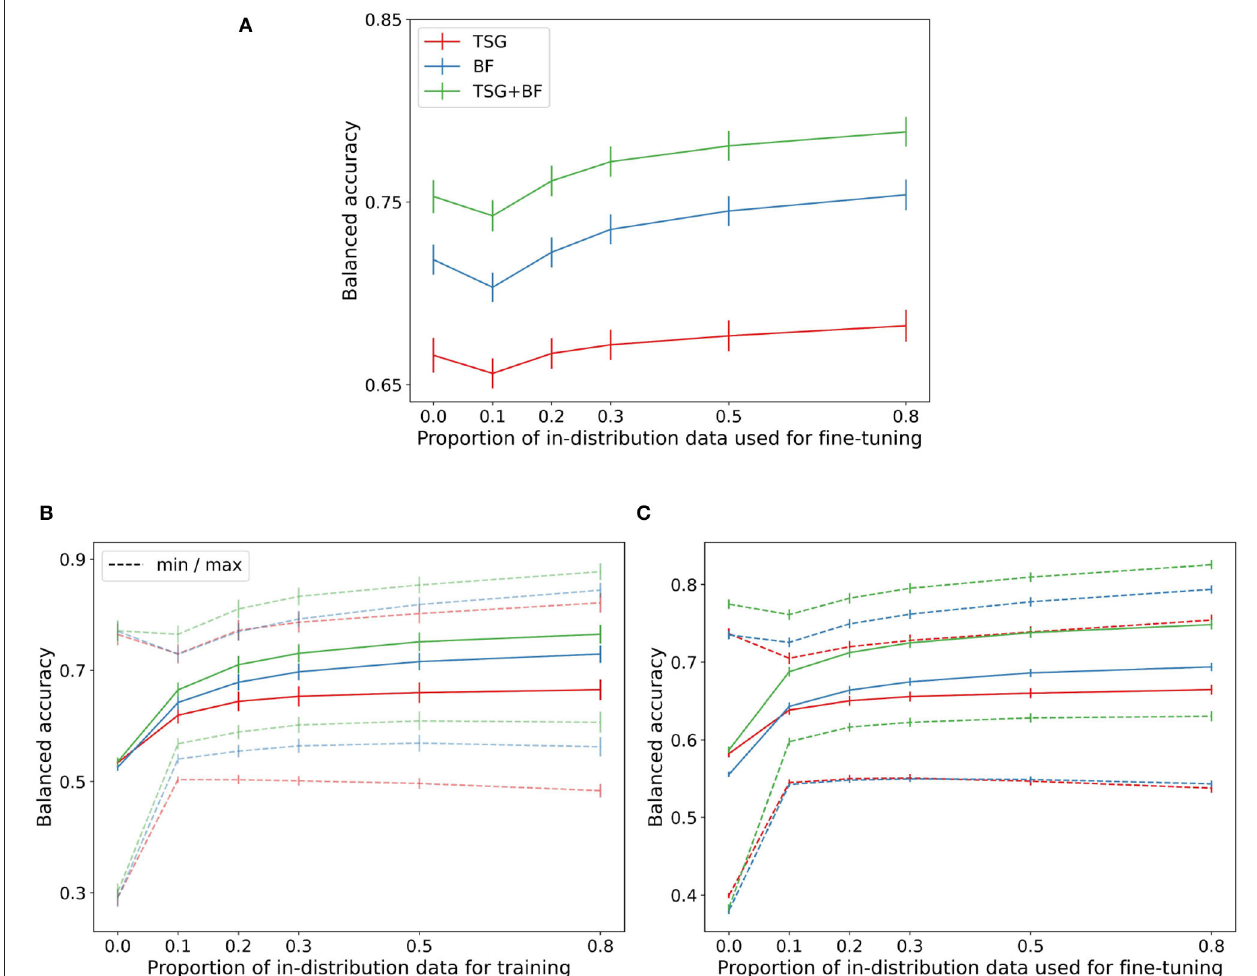
FIGURE 4 | Transfer results. (A) MATB-II (across session). (B) Mental Math (across subject). (C) MATB-II (across